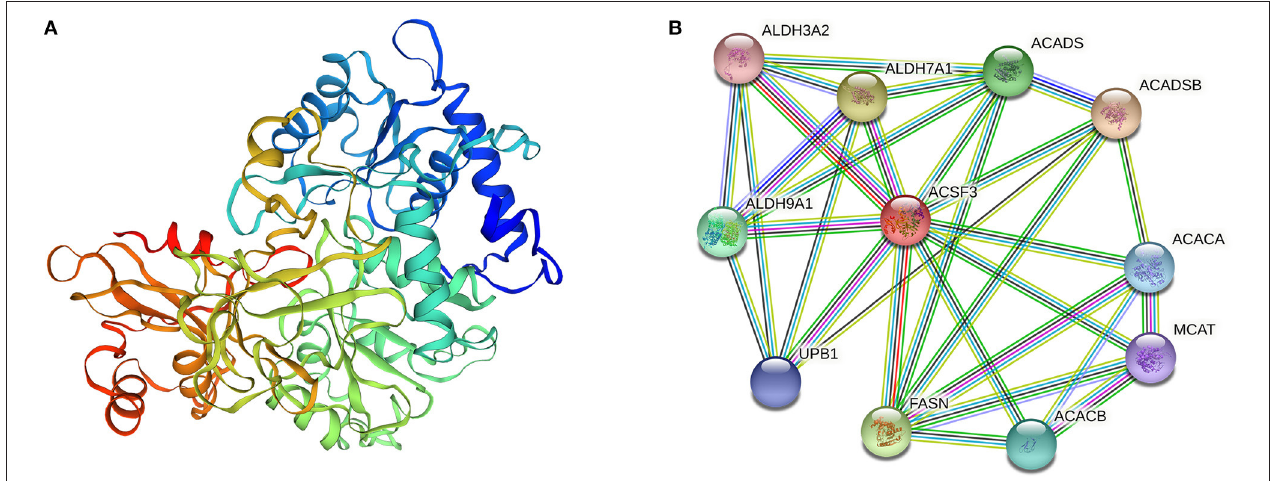
FIGURE 1 | ACSF3 gene structure prediction and protein interaction prediction in lipid metabolism pathways (14, 15). (A) Tertiary structure of ACSF3 protein (prediction). (B) Interacting proteins for ACSF3 gene in lipid metabolism pathway of